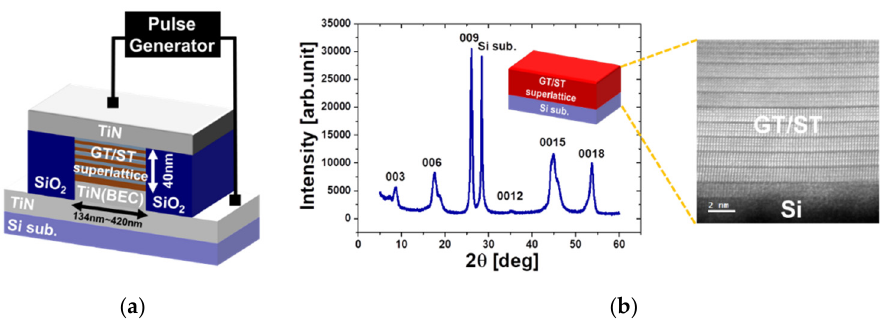
Figure 1. ( a ) Schematic of the fabricated GeTe/Sb 2 Te 3 (GT/ST) interfacial phase-change memory (iPCM) structure, ( b ) XRD diffraction pattern of a GT/ST SL (SL) structure and cross-sectional TEM image of the GT/ST superlattice on an Si (111) substrate.